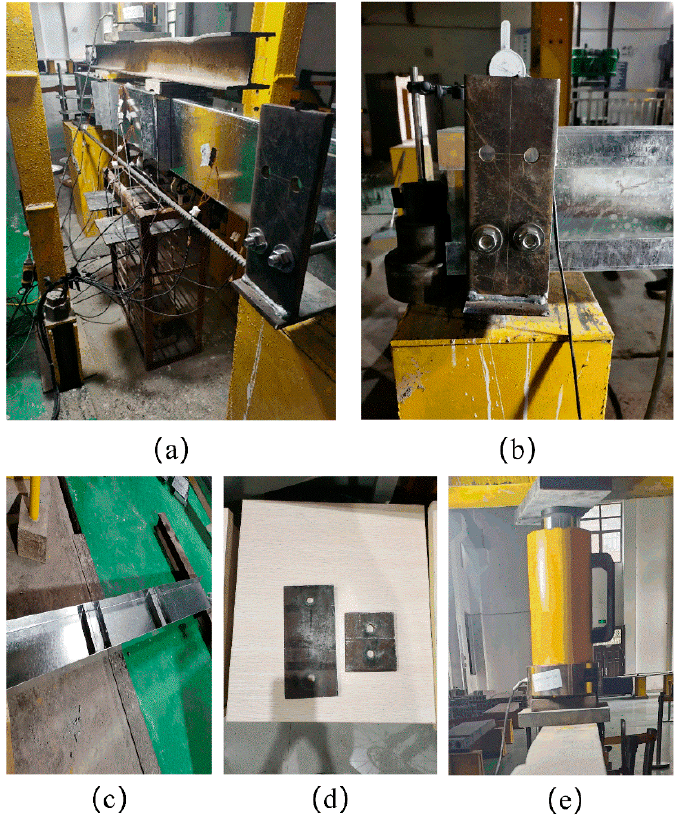
Figure 6. Test setup for B4 beam. ( a ) Overall view; ( b ) Fixture; ( c ) Reinforcement components; ( d ) Load transfer plates with holes; ( e ) Hydraulic jack and load cell.